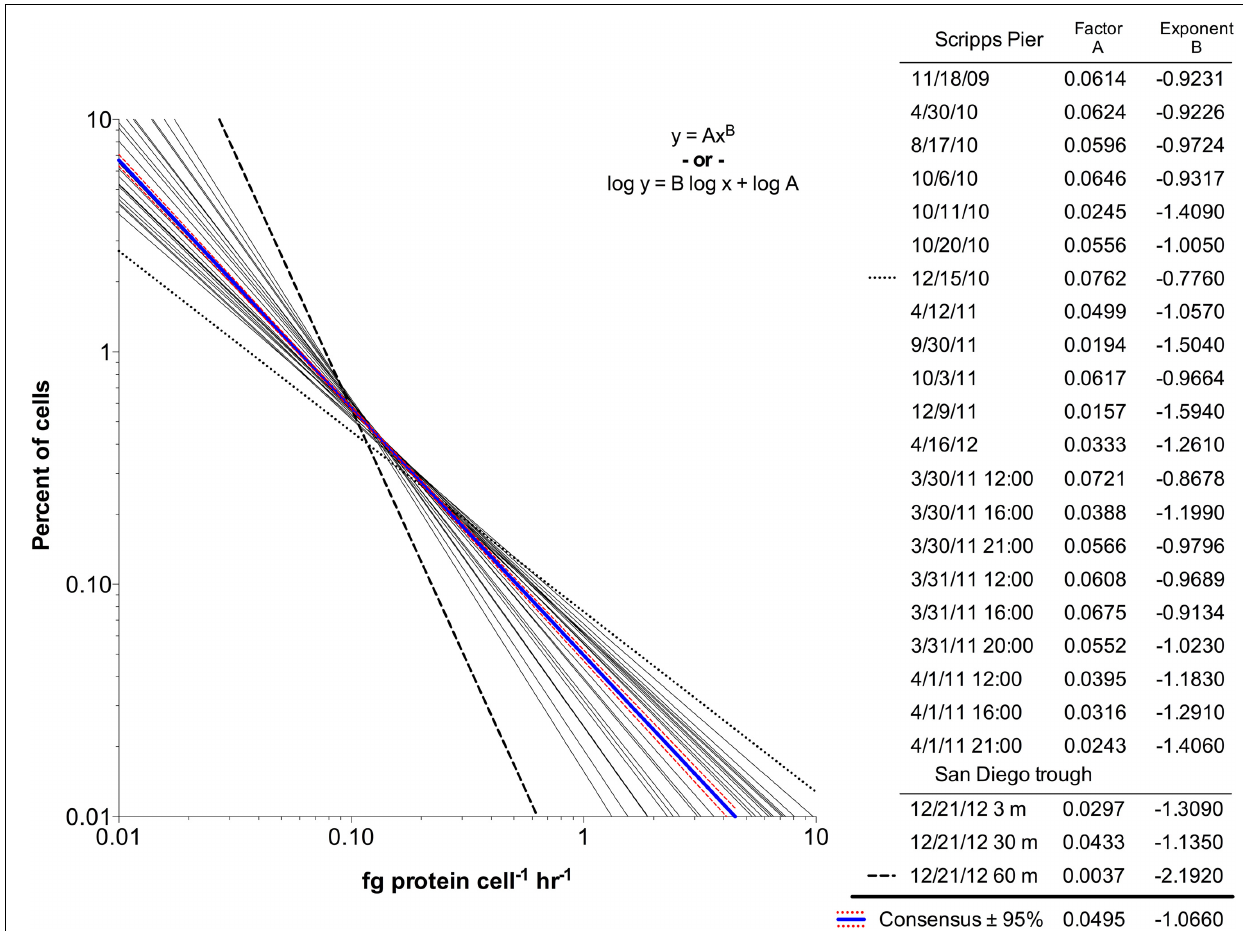
FIGURE 4 | Single cell protein production rate distribution for 24 bacterial community samples from Scripps Pier and San Diego offshore trough seawater. The rate distributions fit power law regressions, and the parameter